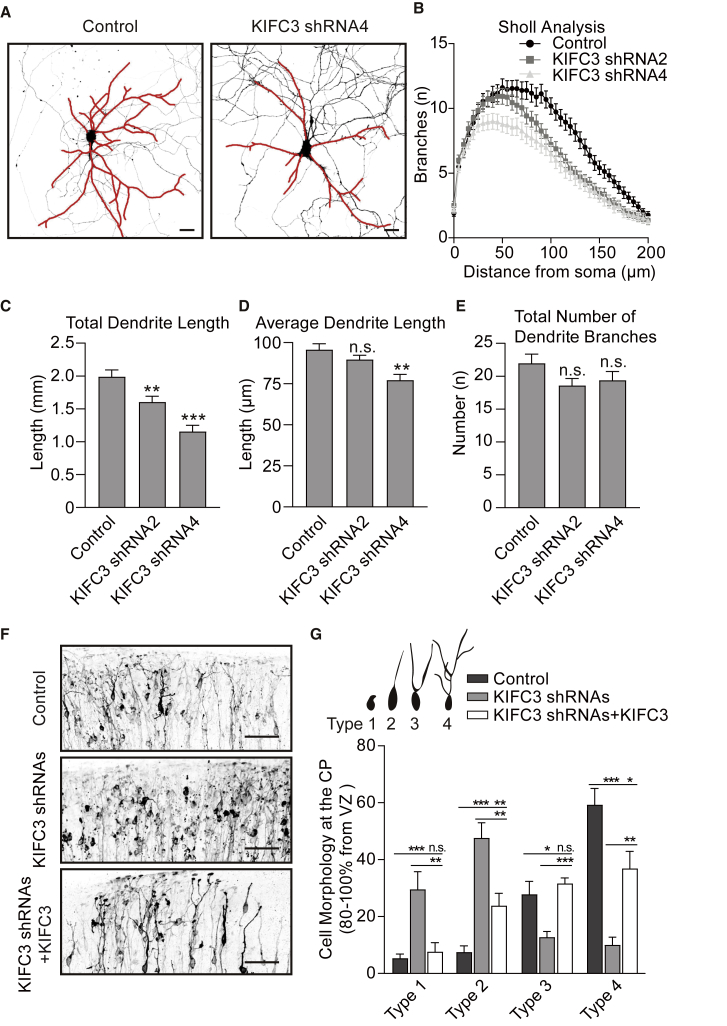
KIFC3 Is Important for Dendrite Branching(A and B) DIV11 hippocampal neurons expressing GFP and pSuper-scrambled shRNA as a control or KIFC3 shRNAs. shRNA efficiency was indicated in Figures S1A and S1B.(A) Representative images of the neurons with the dendrites marked in red. Scale bars, 25 μm.(B) Sholl analysis of the dendritic branching upon control and KIFC3 depletion. Control: N = 7, n = 46; KIFC3 shRNA2: N = 7, n = 57; KIFC3 shRNA4: N = 5, n = 36. Error bars represent SEM. Significant difference was shown in Figure S1C.(C–E) Quantification of the neurons described in (A) and (B). Total dendrite length (C), average dendrite length (D), and total number of dendrite branches (E) were quantified. Error bars, SEM. ∗p < 0.05; ∗∗p < 0.01; ∗∗∗p < 0.001 (unpaired t test).(F) Representative images of mouse cortical plate. Same images with larger view were used to quantify migration defects (Figures S1D and S1E). Neurons were transfected with MARCKS-GFP and KIFC3 shRNAs or pSuper-scrambled shRNA. A shRNAs-resistant mCherry-KIFC3 was used for rescue. Scale bars, 50 μm. Control: N = 10, n = 175; KIFC3 shRNAs: N = 8, n = 184; KIFC3 shRNAs+KIFC3: N = 9, n = 264.(G) Quantifications of the neuronal morphology of transfected cells in the cortical plate (CP), defined as 80%–100% of the radial axis from ventricular surface to the pial surface corresponding to (F). Error bars, SEM. ∗p < 0.05; ∗∗p < 0.01; ∗∗∗p < 0.001 (unpaired t test). Schematic diagram was used to show the typical morphology of different type neurons.